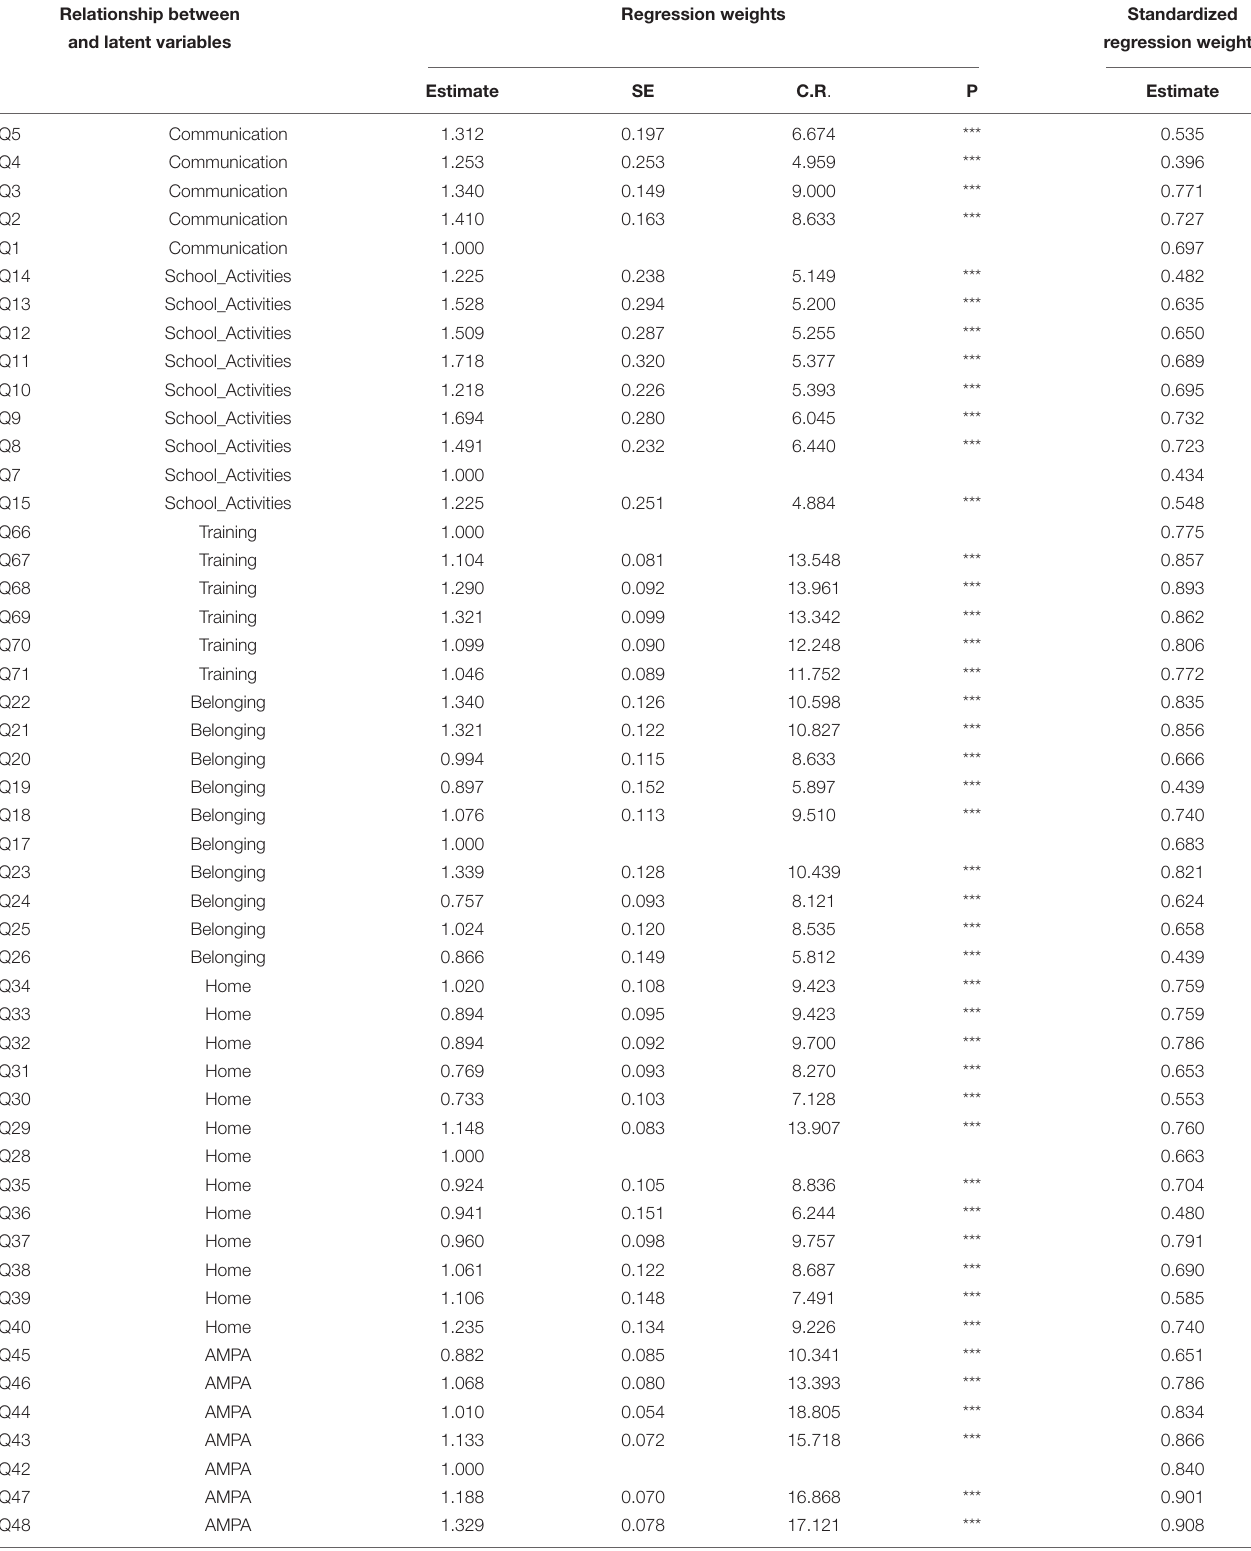
TABLE 4 | Regression coefficients and standardized regression coefficients between observable and latent variables. Relationship